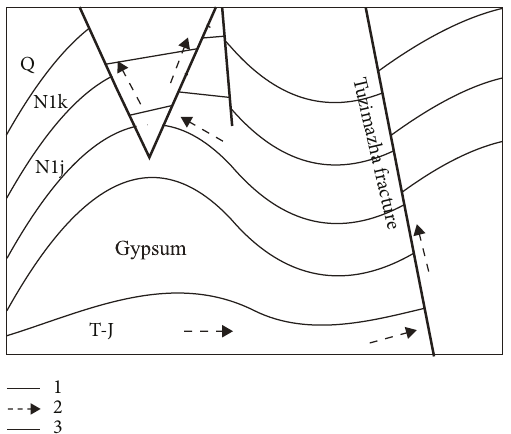
Figure 2: Schematized picture of oil and gas migration in the Dawanqi oil fi eld, based on Yang et al. (2006). (1) Fault and fracture systems, (2) main direction of oil and gas migration, and (3) boundary of geological formations: Q: Quaternary (sandstone, mudstone, and conglomerate); N1k: Neogene Kangcun formation (sandstone, mudstone, and siltstone); N1j: Neogene Jidike formation (sandstone and mudstone); T-J: Triassic and Jurassic coal-bearing formation.